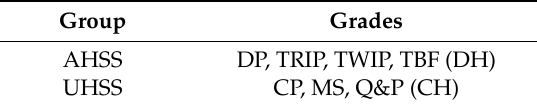
Table 3. AHSS and